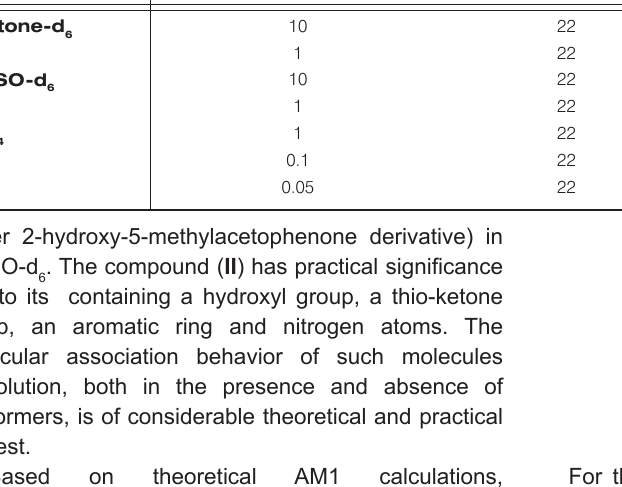
) of (Z)-1-(2-hydroxy-5-methyl-3-nitrophenyl) et ha no ne oxime ( I ) in different solvents at 22 0 C. OH